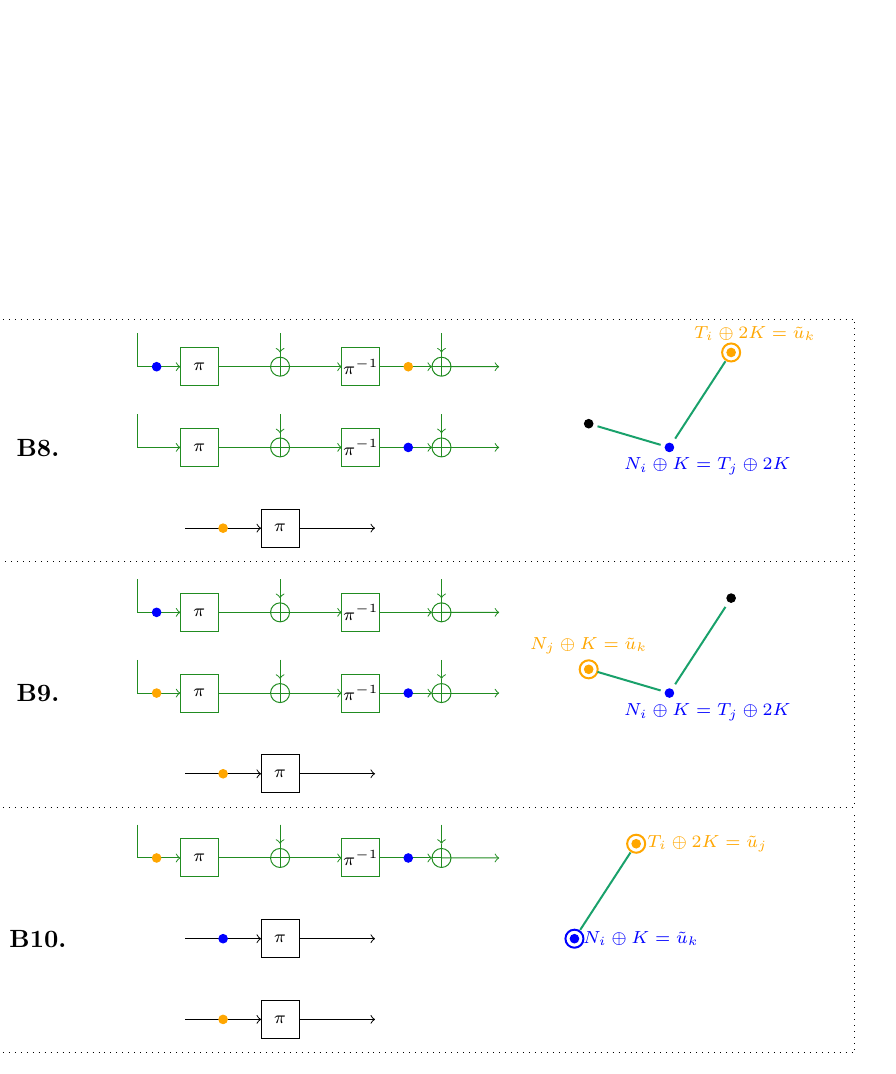
Figure 10: Collisions amongst authentication queries and primitive queries - Figurative and graphical representations of the bad